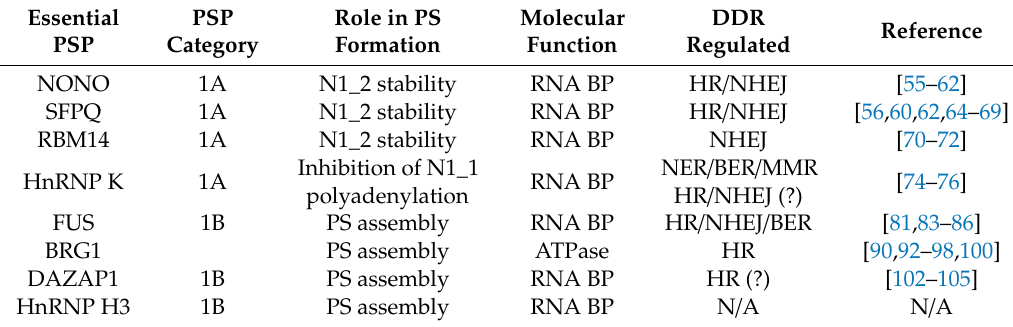
Table 1. DDR system regulated by essential